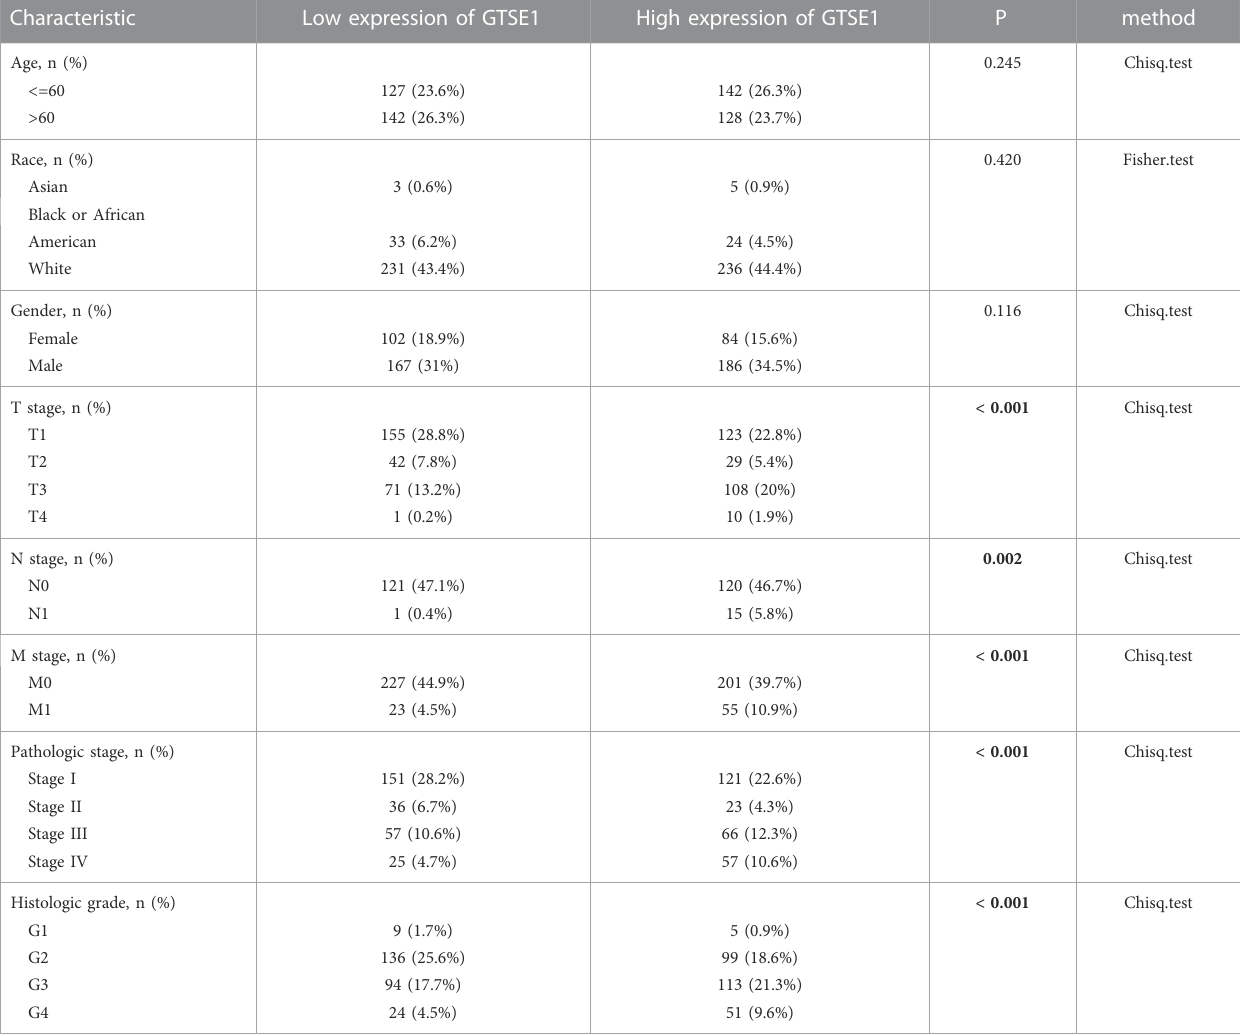
TABLE 2 Relationship between GTSE1 expression and clinicopathological features in patients with ccRCC.